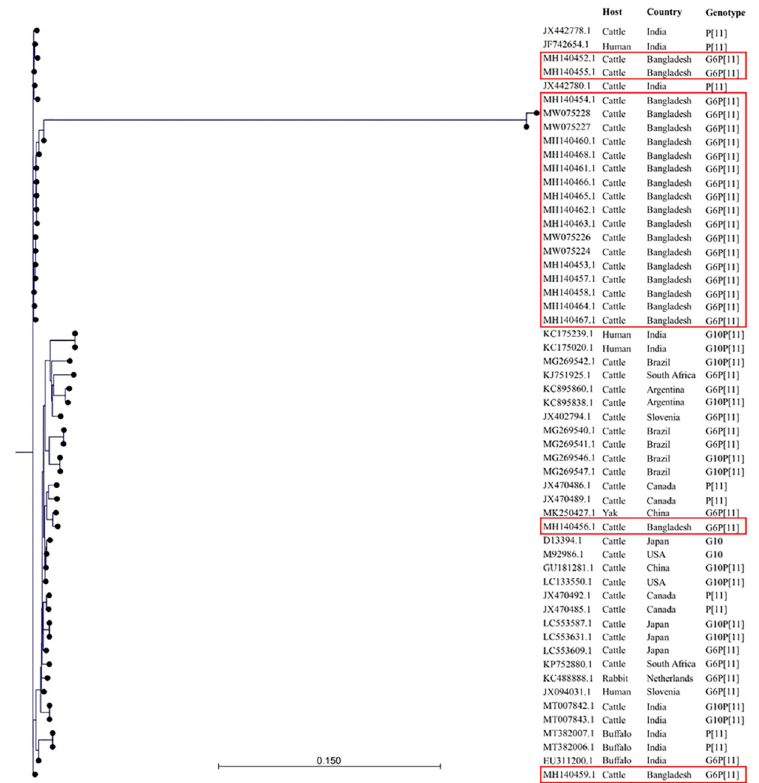
Fig 5. The evolutionary relationship of P11-VP4 genes of bovine rotaviruses detected in the present study (red rectangle). The tree was constructed with the aligned sequences downloaded through BLAST search. The relationship was inferred using the Neighbor-Joining method and the nucleotide distances were measure using Kimura 80 model on CLC Sequence viewer 8.0. The scale bar at the bottom indicates nucleotide substitutions per site.